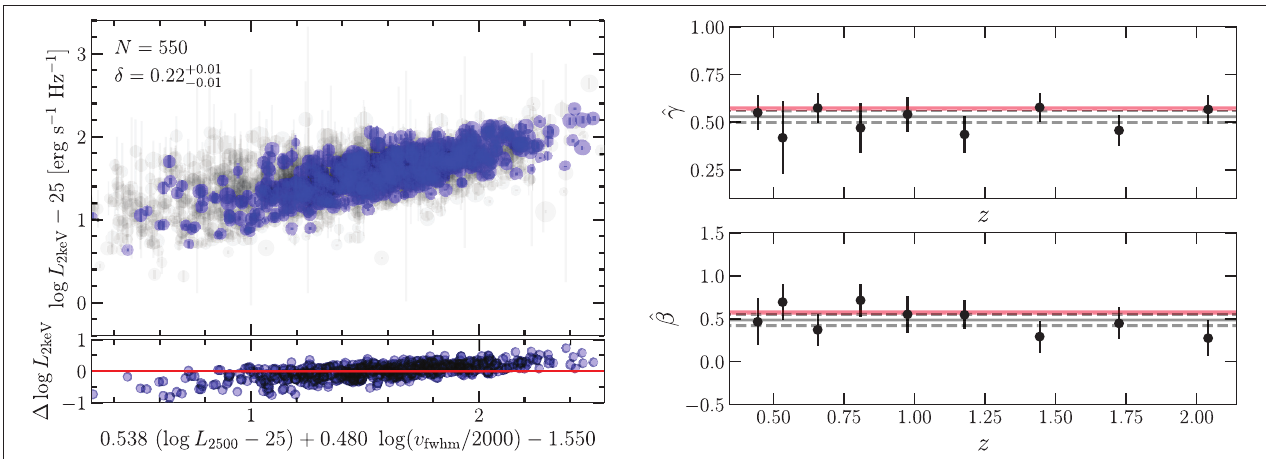
L UV FWHM plane (seen edge-on) for the z < 2.3 SDSS-3XMM-DR6 quasar sample in Lusso and Risaliti (2017). The full-width half FIGURE 1 | Left: The tight L X − − maximum ( FWHM ) is computed from the Mg II emission line. The size of the points has been rescaled to the FWHM value, the smaller size corresponds to FWHM 2000 km/s. The slopes of this correlation are in very good agreement (within the uncertainties) with the ones predicted by our simple (but physically = L ˆ γ UV FWHM ˆ β , where γ β 4 / 7 (4 / 7 0.571). The quasar sample before applying our filters is also plotted with light gray points. Right: motivated) model, L X ˆ = ˆ = ∼ ∝ L UV FWHM plane as a function of redshift. The red solid line represents the predicted value of 4 / 7. The observed L X Slopes of the L X − − not evolve with redshift up to z 2.3, which is an essential requirement in order to utilize this relation to measure cosmological parameters. The gray solid and dashed ∼ lines represent the weighted means and uncertainties of the black points, respectively. Figure based on data derived from Lusso and Risaliti (2017).